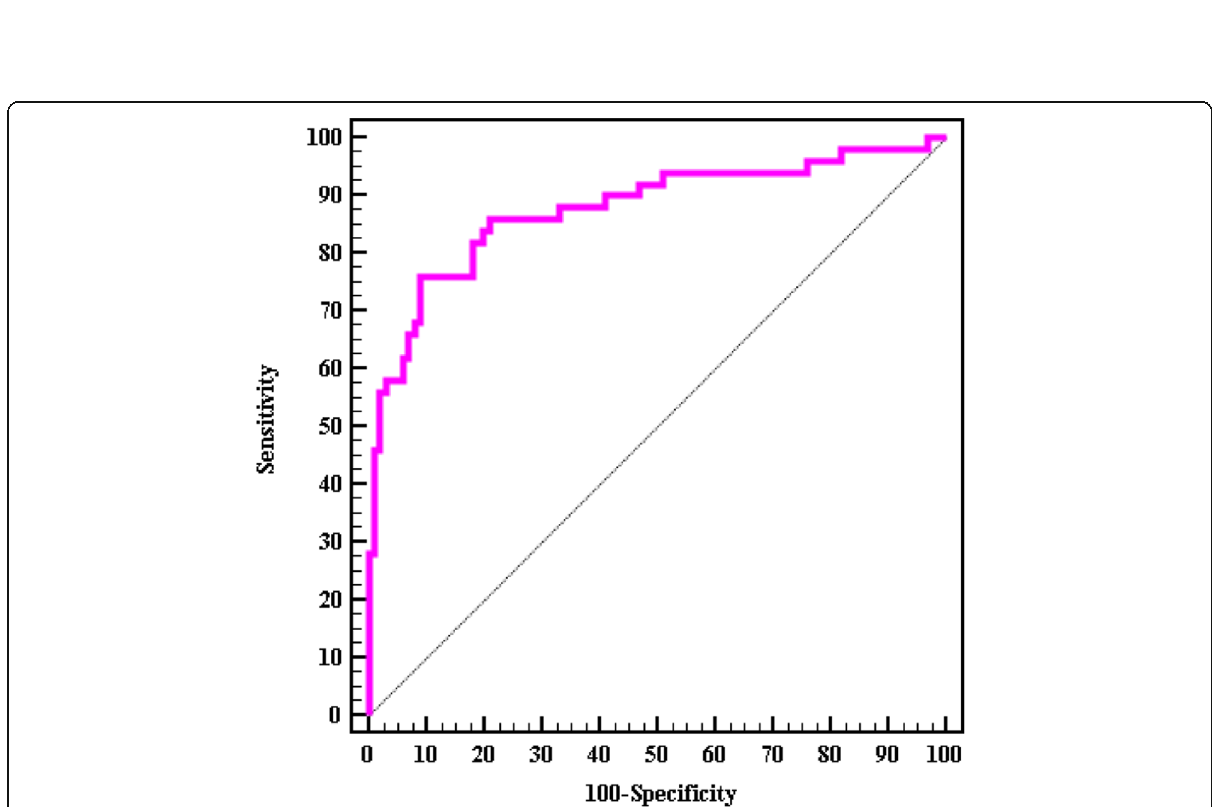
Fig. 4 ROC curve for the combination of AFP and miR-331-3p to predict early-stage HCC patients (group II) from HCV-related cirrhosis (group